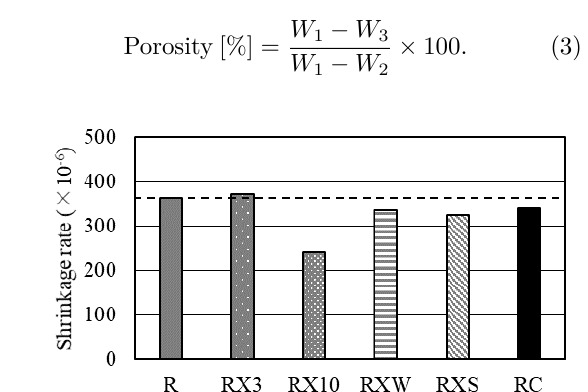
Figure 4. Drying shrinkage rate.